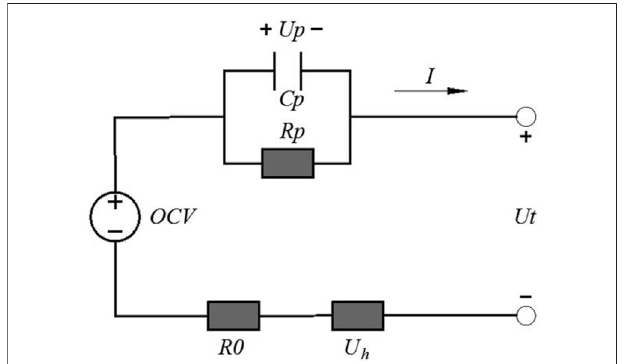
FIGURE 3 | The fi rst-order RC model with the hysteresis voltage.